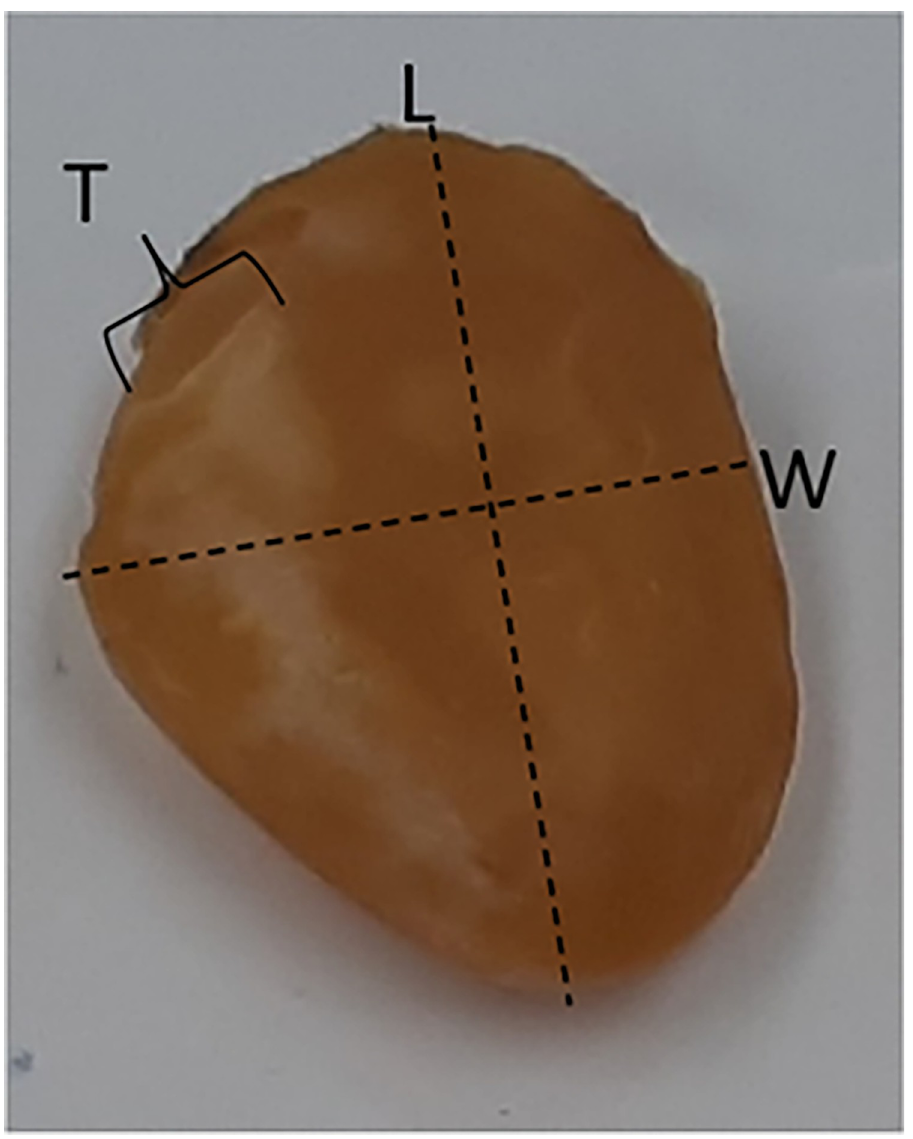
Fig 1. A representation of the axial dimensions of S . madagascariensis